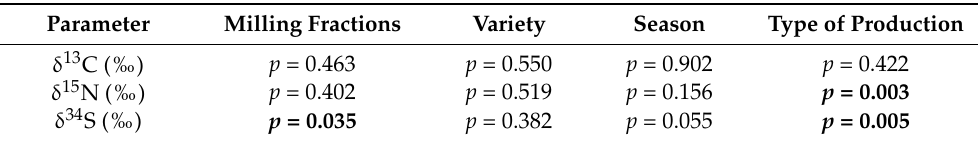
Table 3. The univariate statistical evaluation results for selected parameters ( p -values; confidence interval 95%). p -values in bold show a significant